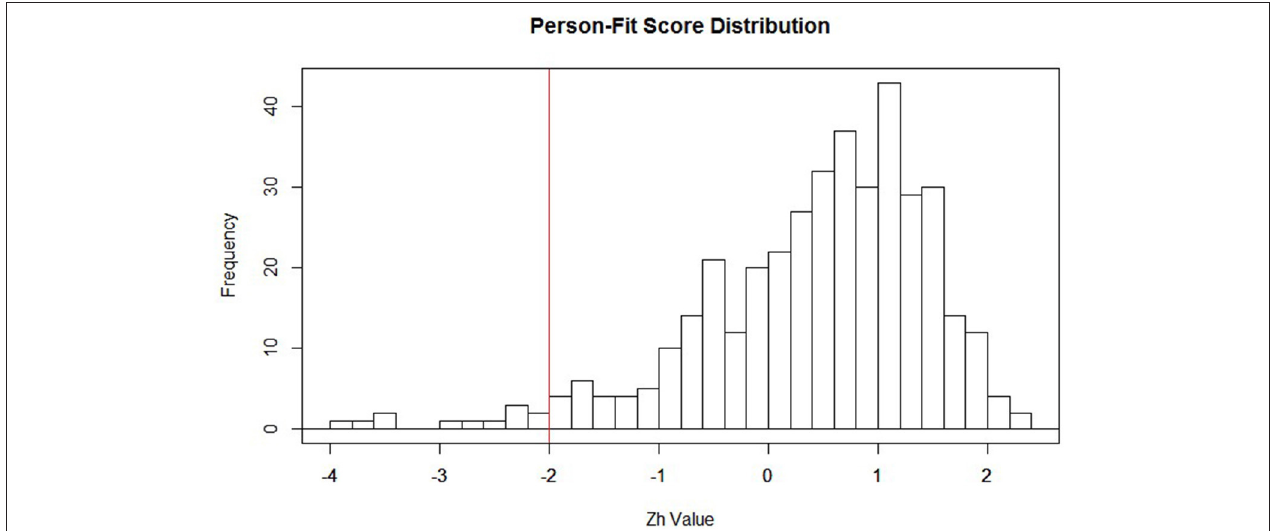
FIGURE 1 | Distribution of Zh values with − 2 highlighted in red. This is not a strict cutoff; it is suggested researchers create a cutoff that best highlights important features of the distribution. For example, if the interest is in assessing over-fit, then the cutoff would be placed at the higher end of the distribution (e.g., around 2).